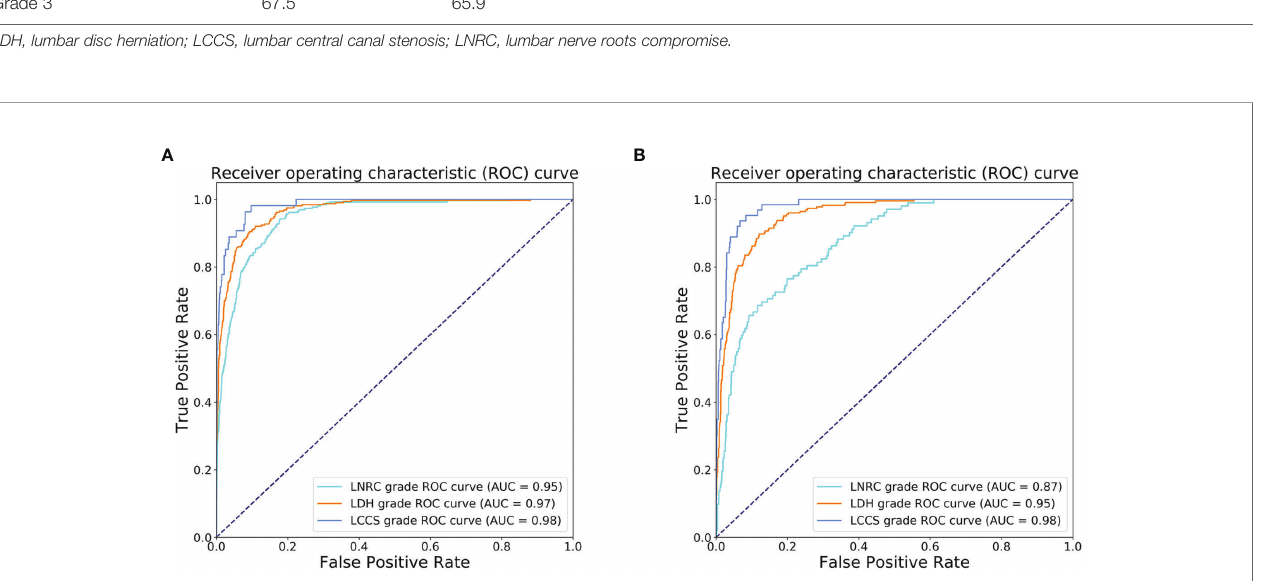
TABLE 4 | The accuracy performance of the multi-task classi fi cation model on the external test dataset. Predicted Grading Precision (%)